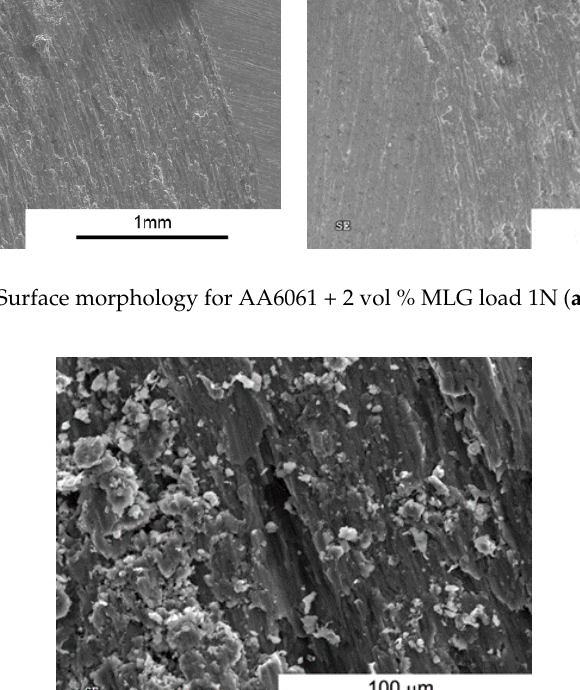
Figure 15. Worn Surface morphology for SPS AA6061+2 vol % MLG load 5N.